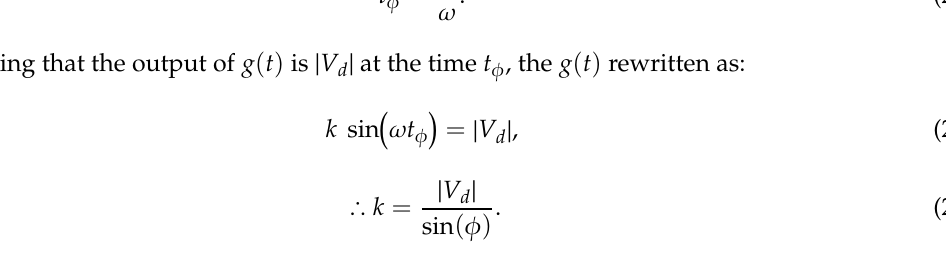
Figure 11. TCV with slope of the width φ .